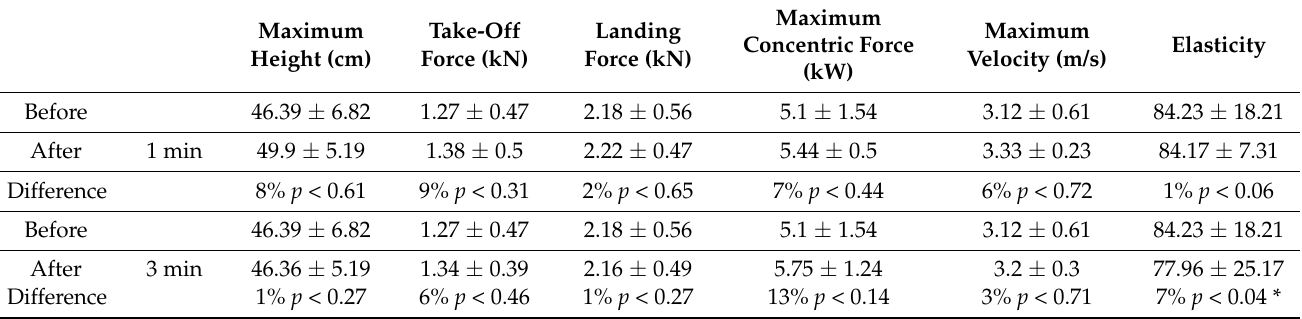
Table 3. Mean values and standard deviation of selected component parameters of the